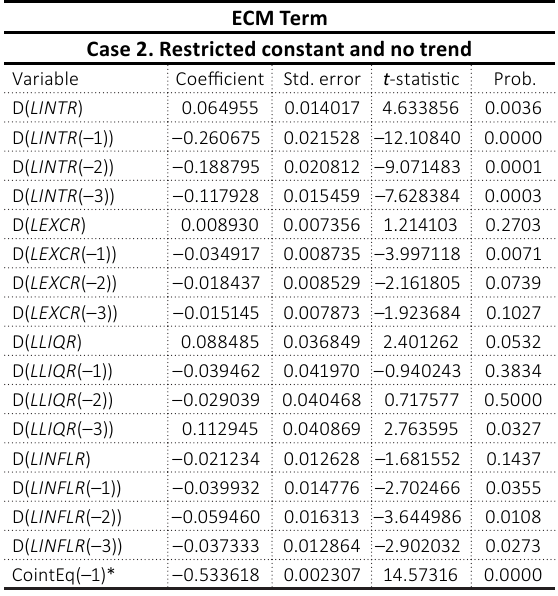
Table 6. ARDL error correction term